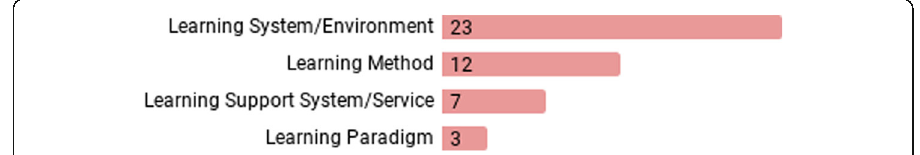
Fig. 3 Varying concepts of smart learning environments and